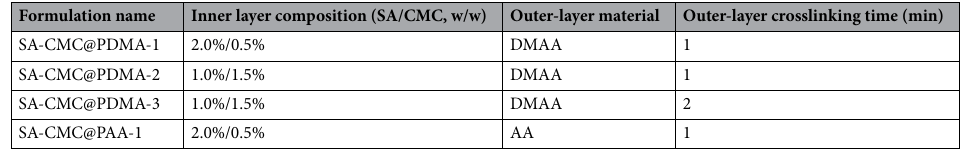
Table 1. The composition of double-layer